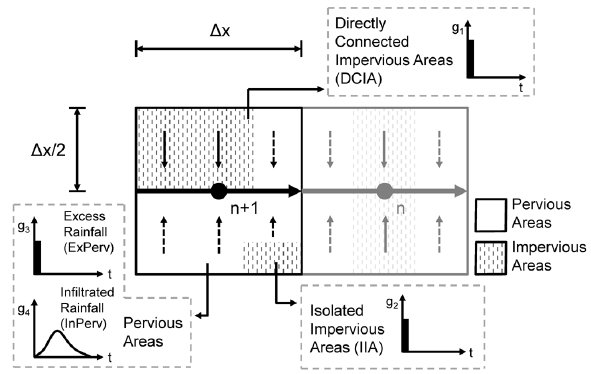
Fig. 1. Response functions from excess rainfall and infiltrated rain- fall contributing to runoff